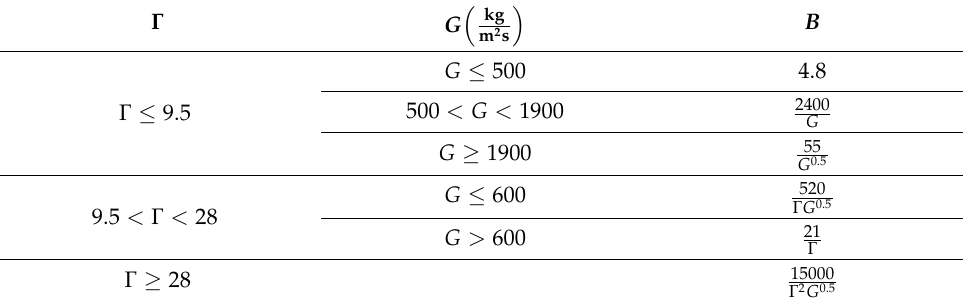
Table 1. Values of B in the Baroczy–Chisolm